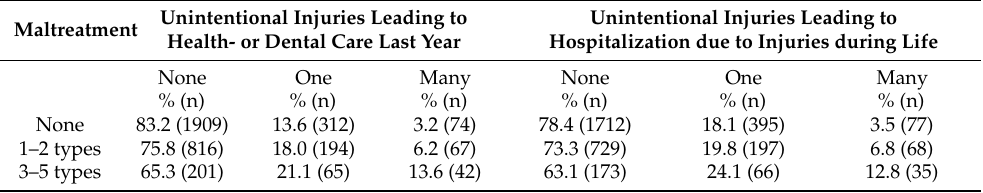
Table 5. Dose-response association between number of maltreatment types (during life) and uninten- tional injuries leading to health- or dental care in the last year and hospitalization during